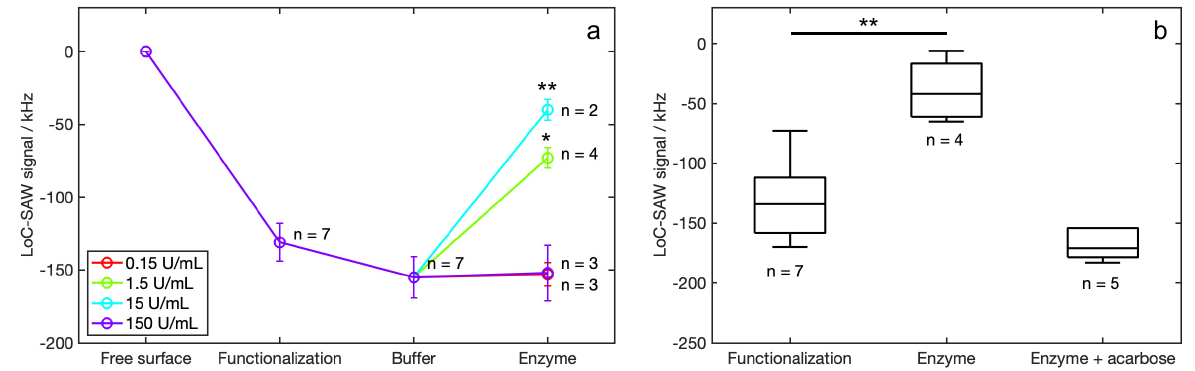
Figure 4. Measures performed with the SAW-LoC device: ( a ) characteristic curve obtained analyzing samples containing α -glycosidase in concentrations ranging from 0.15 to 150 U/mL; ( b ) frequency shifts measured analyzing samples containing α -glycosidase (15 U/mL) and its inhibitor acarbose (2.5 mg/mL), compared to those obtained after the functionalization and the injection of samples containing only the enzyme (15 U/mL); n indicates the number of sensors used for each analysis; statistical tests are performed comparing the frequency shift from functionalization and from samples, * indicates p < 0.1, while ** indicates p < 0.01, obtained from a Mann–Whitney U-test.